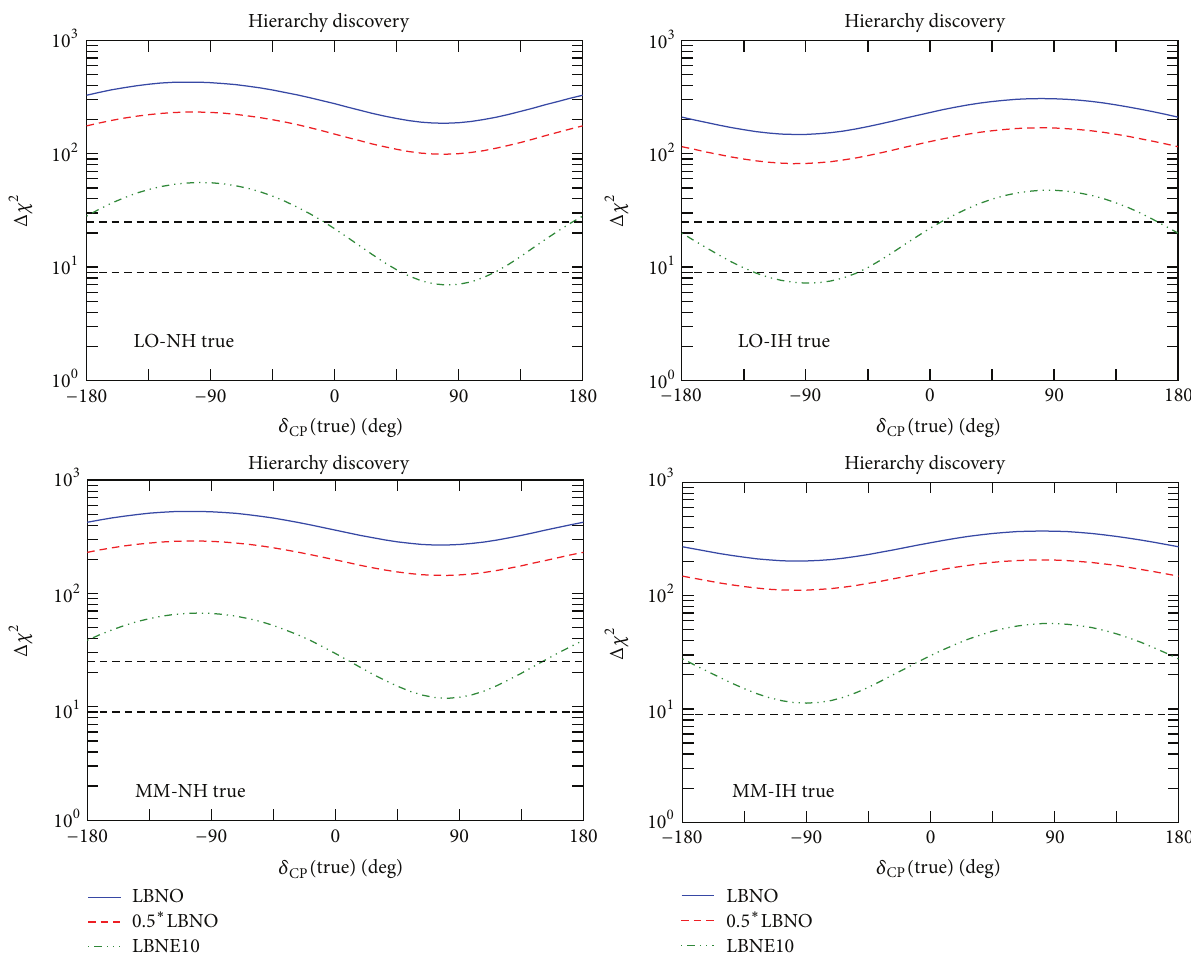
Figure 14: Hierarchy discovery reach for LBNO, 0.5 ∗ LBNO and LBNE10. Results are shown for the four possible true 𝜃 23 -hierarchy